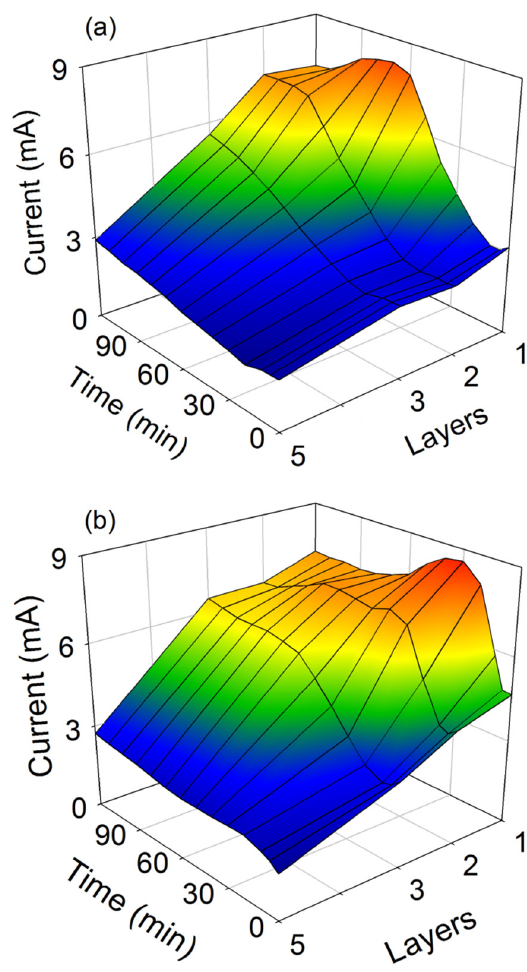
Figure 12. Current vs. Time for TiO of deposited layers for: (a) unmodified and (b) modified